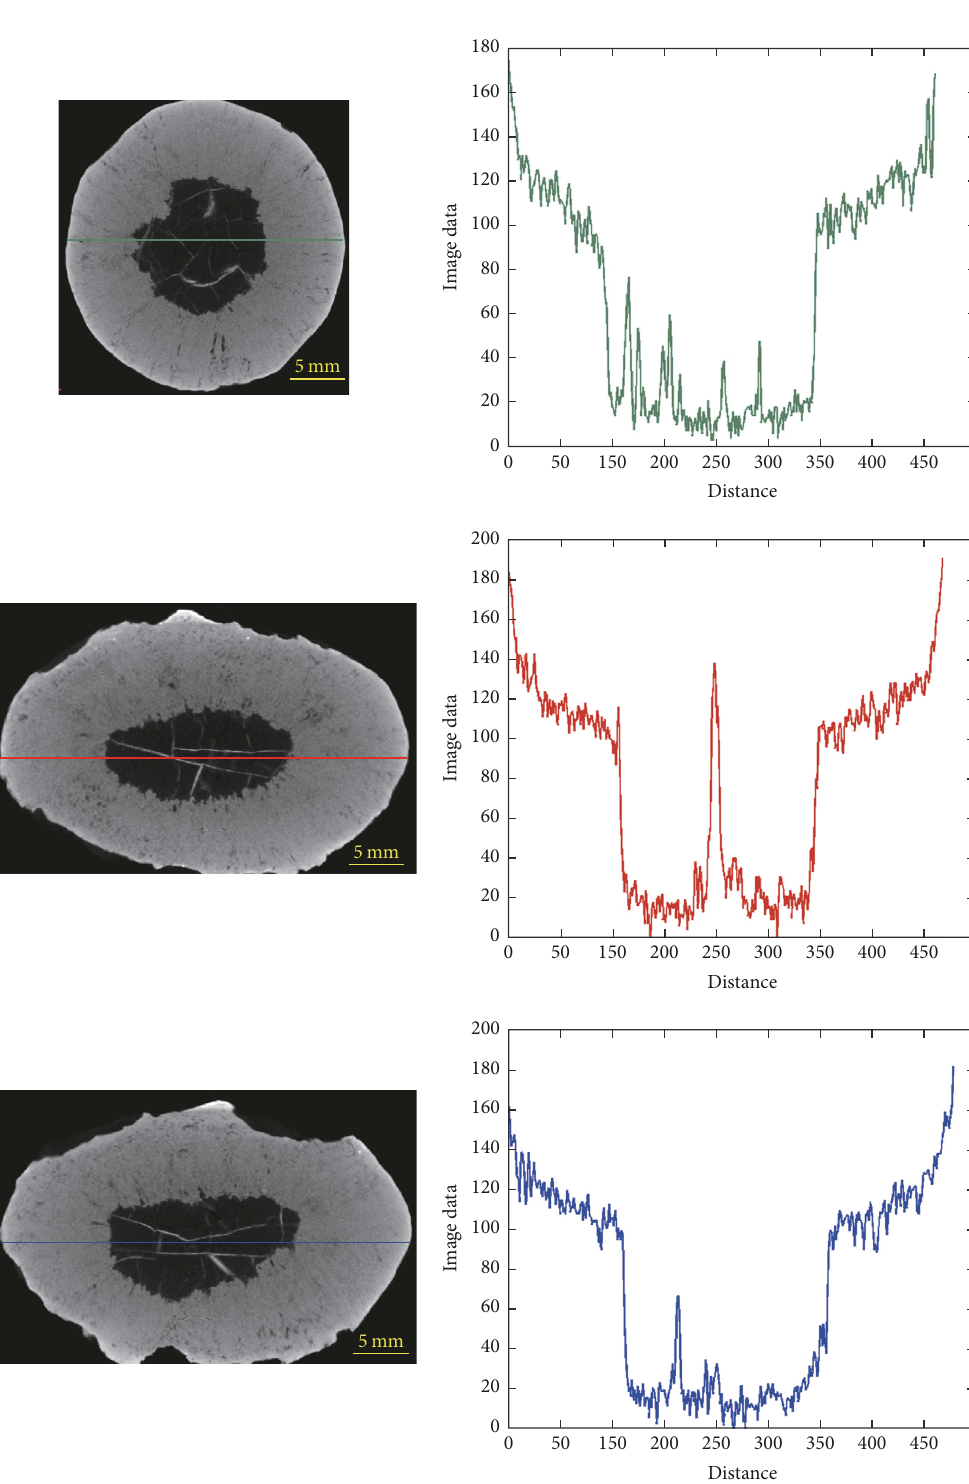
Figure 3: Sudden X-ray signal changes in the shell and core show great material density differences between internal and external substances. The concretion sample was the same as that in Figure